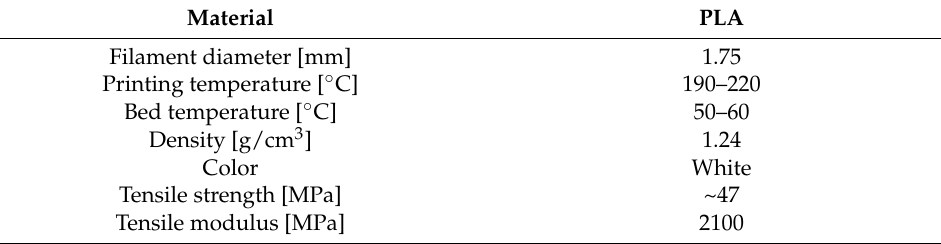
Table 1. PLA material properties